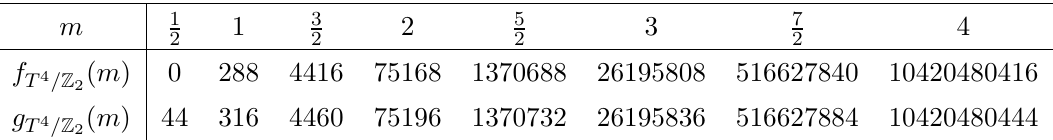
( m ) and g ( m ), de(cid:12)ned in T 4 = Z 2 T 4 = Z 2